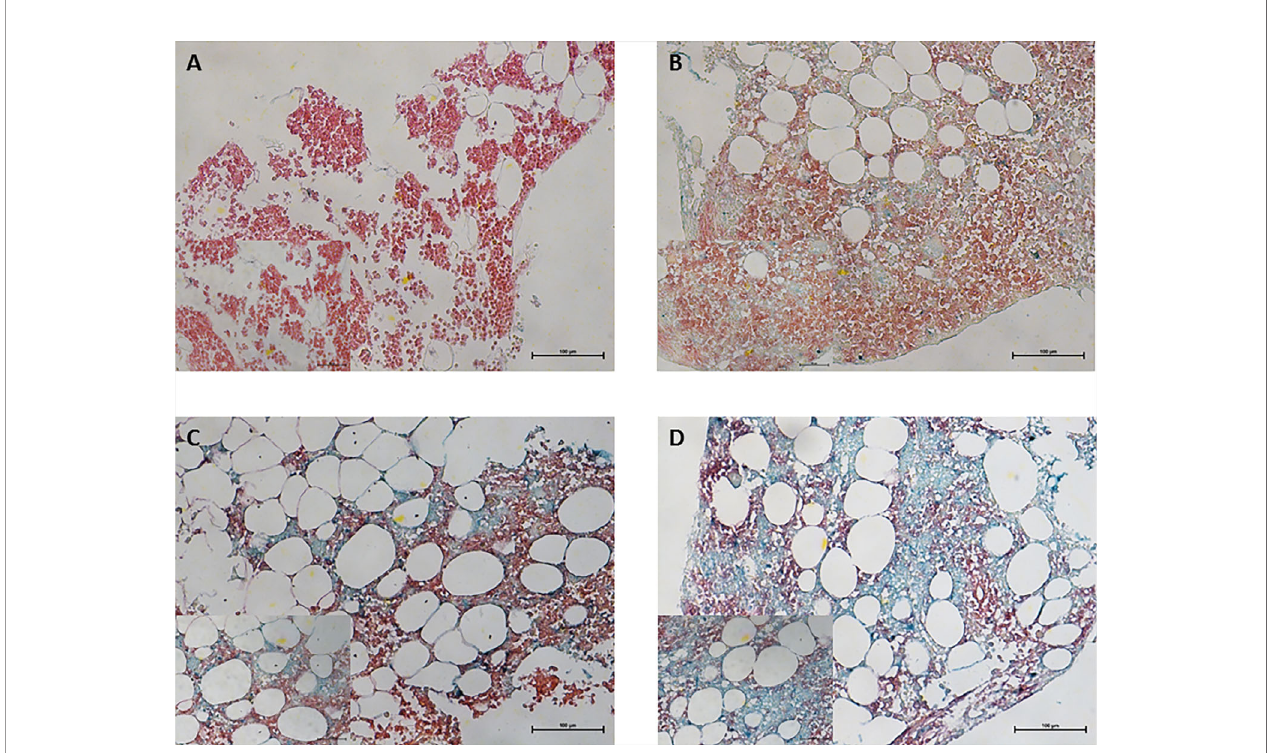
FIGURE 1 | Immunohistochemical staining for CRBN expression in bone marrow plasma cells obtained from multiple myeloma patients. CD138 + plasma cells was performed using Permanent Red chromogen (red color) and CRBN-expressing cells were stained using Emerald chromogen (blue-green color). Representative images for the high and low CRBN expression based on H-score. (A) 0 and (B) 4 for low CRBN expression and (C) 6 and (D) 8 for high CRBN expression. Top row, original magni fi cation ×200; bottom low inset, original magni fi cation received IMiD-based therapy and non-IMiD therapy were NR (not reached) and 64 months, respectively. A signi fi cant difference was observed for OS between the two groups [hazard ratio (HR), 1.862; 95% CI, 1.044 – 3.320; P = 0.03; Figure 4A ]. The median PFS of patients who received IMiD- based therapy and non-IMiD therapy were 34 and 19 months, respectively and there was no signi fi cant difference between the two groups (HR, 1.343; 95% CI, 0.868 – 2.076; P = 0.17; Figure 4B ). In patients with high CRBN expression, the median OS and PFS of patients who received IMiD-based therapy and non-IMiD therapy were NR and 54 months for OS and 29 and 10 months for PFS, respectively. IMiD-based therapy was signi fi cantly associated with better OS (HR, 2.881; 95% CI, 1.338 – 6.203; P = 0.005; Figure 4C ) and PFS (HR, 1.911; 95% CI, 1.085 – 3.366; P = 0.01; Figure 4D ). In patients with low CRBN expression, the median OS and PFS of patients who received IMiD-based and non-IMiD therapy were 45 months and NR, for OS and 31 and 32 months, for PFS, respectively. However, IMiD-based therapy was not signi fi cantly associated with better OS (HR, 0.795; 95% CI, 0.319 – 1.978; P = 0.61; Figure 4E ) and PFS (HR, 0.854; 95% CI, 0.403 – 1.810; P = 0.67; Figure 4F ). In summary, the IMiD-based therapy affected the prognosis of myeloma in patients with high CRBN expression; however, it did not affect the prognosis of patients with low CRBN expression.